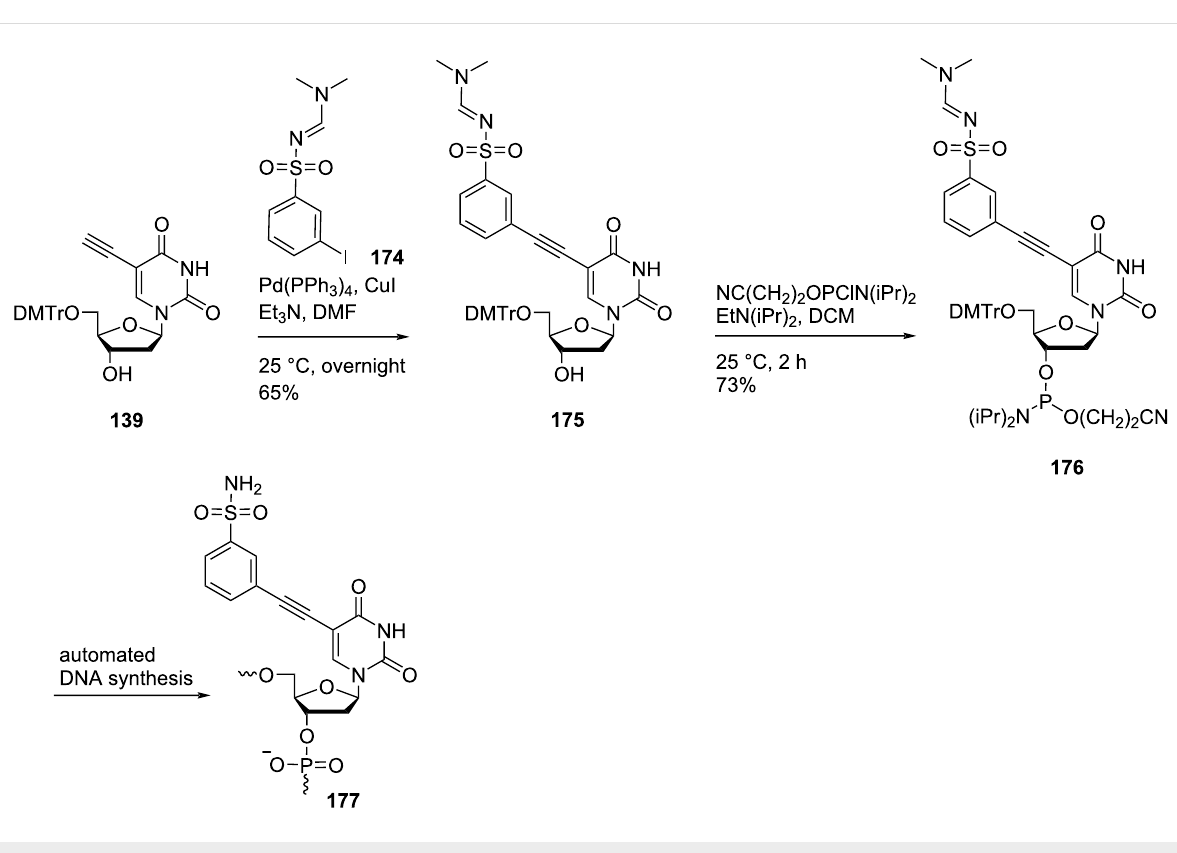
Scheme 45: Synthesis of double-headed nucleoside 175 , phosphoramidite 176 , and the corresponding nucleotide monomer 177 .